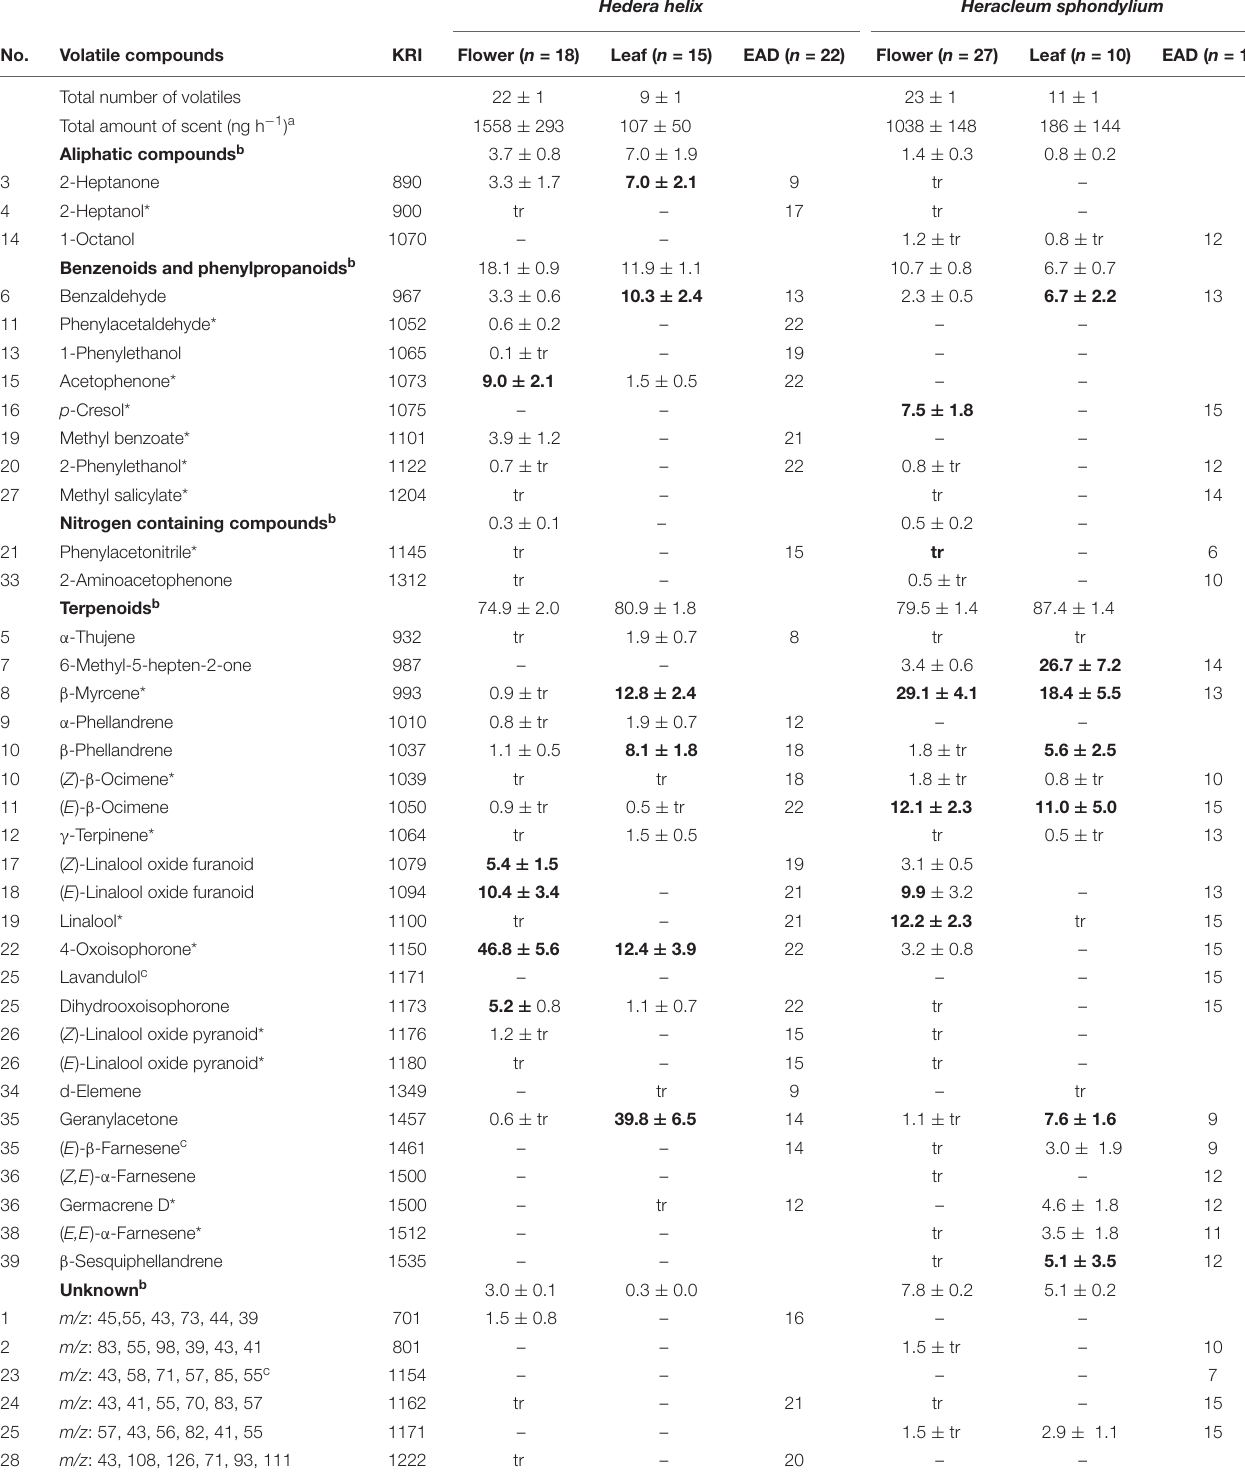
TABLE 1 | Total and relative amounts (mean ± standard error, tr, trace amounts < 0.5%) of electrophysiologically active volatiles in antennae of Vespula germanica / Vespula vulgaris wasps (EAD: number of responding antennae) detected in floral scent samples of Hedera helix and Heracleum sphondylium